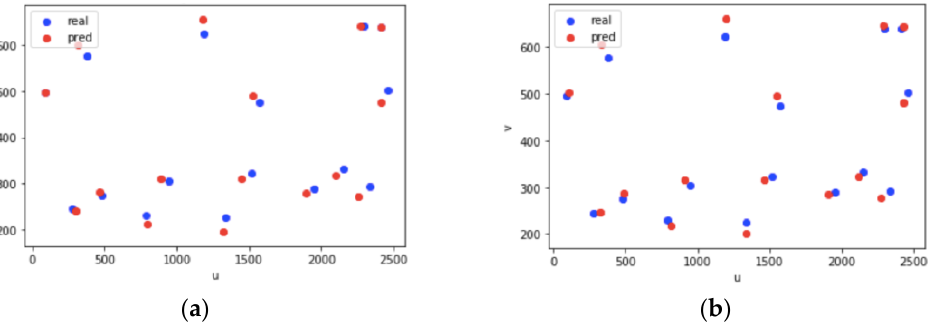
Figure 12. Projection results for scene A: ( a ) projection results before optimization; ( b ) optimized projection results.